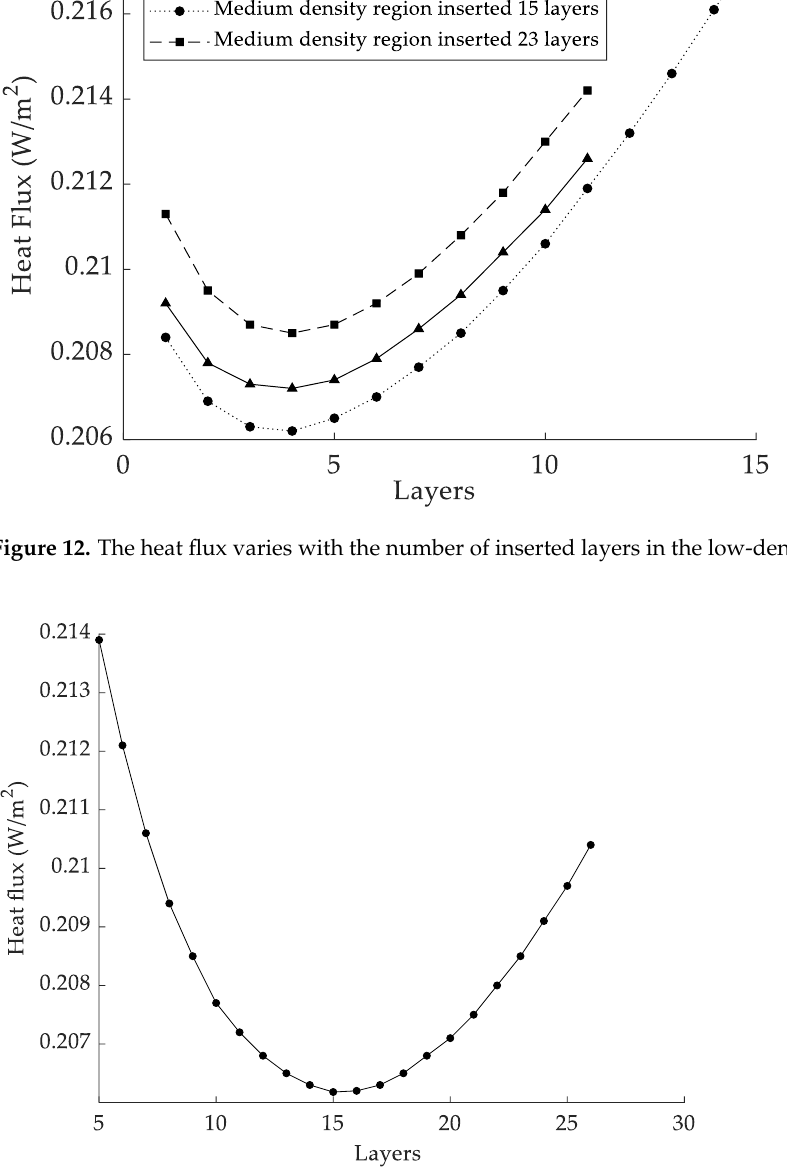
Figure 13. Variation in heat flux with the number of insertion layers in the medium-density re- gion.